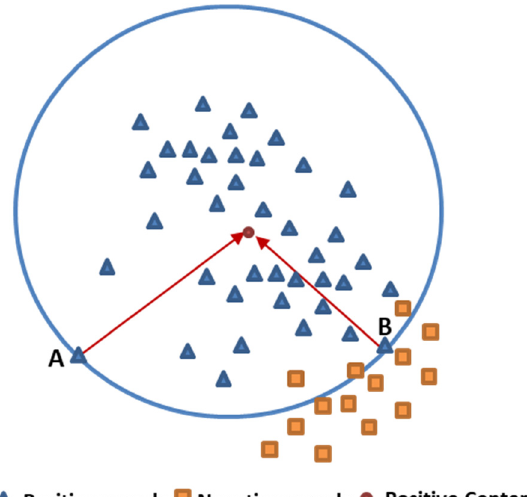
Figure 4. Schematic diagram of the relationship between sample distribution and membership.